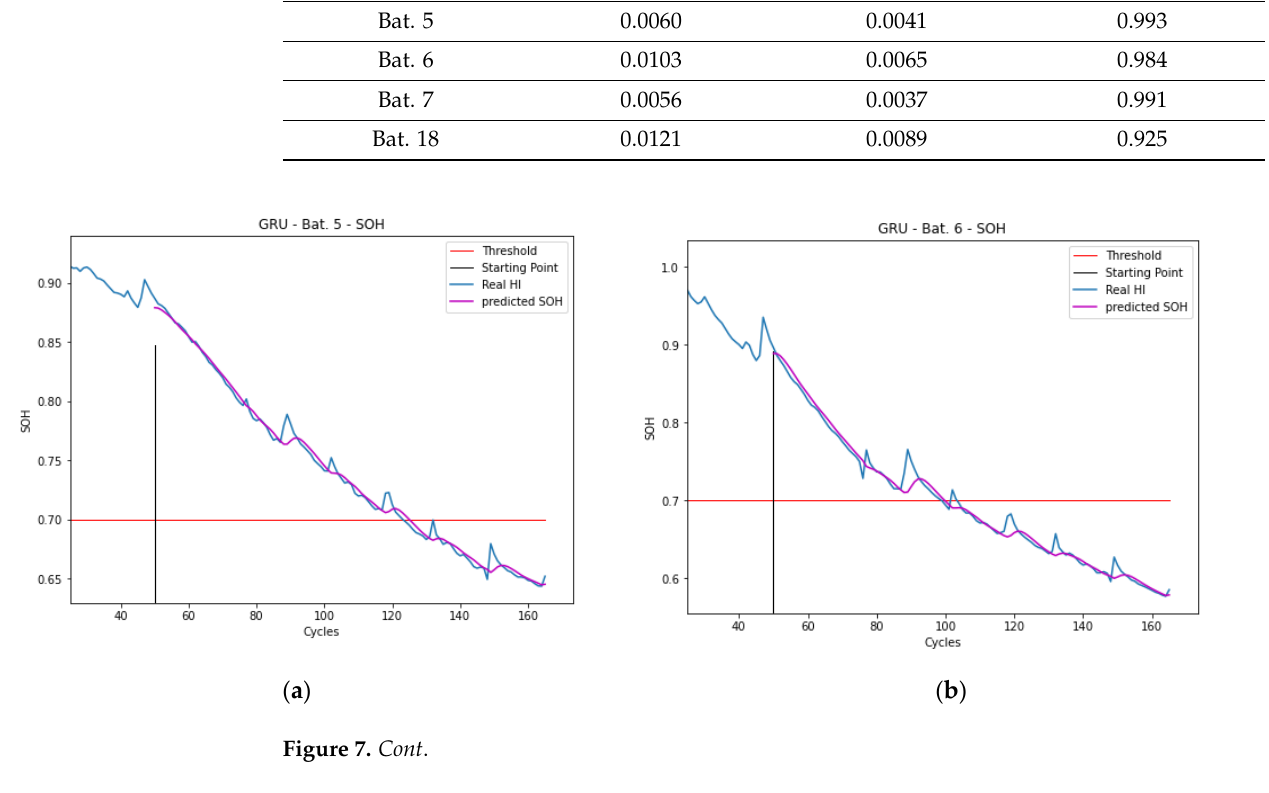
Table 4. The evaluation metrics for the SOH estimations at starting points 0.3. Battery